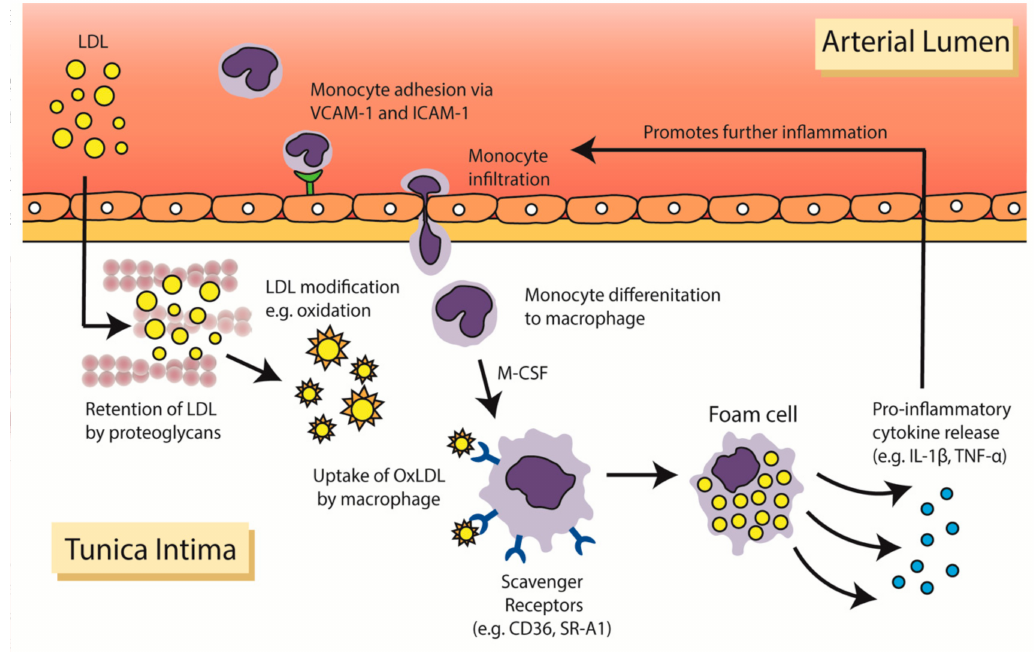
Figure 1. Infiltration of low-density lipoprotein (LDL) and formation of macrophage foam cells in the arterial wall. In individuals with hypercholesterolaemia, elevated levels of LDL-C are prone to infiltration and retention in the arterial wall. Monocytes recruited into the arterial wall di ff erentiate into macrophages on stimulation by macrophage colony stimulating factor (M-CSF). Modified LDL particles are then taken up by macrophages via scavenger receptors. Accumulation of lipids in the macrophage results in the formation of lipid-laden foam cells leading to the release of pro-inflammatory cytokines. CD36, cluster of di ff erentiation-36; ICAM, intercellular cell adhesion molecule 1; IL-1 β , interleukin-1-beta; LDL-C, low-density lipoprotein cholesterol; M-CSF, macrophage colony stimulating factor; oxLDL, oxidised low density lipoproteins; TNF- α , tumor necrosis factor alpha; SR-A1, scavenger receptor type 1; VCAM-1, vascular cell adhesion molecule